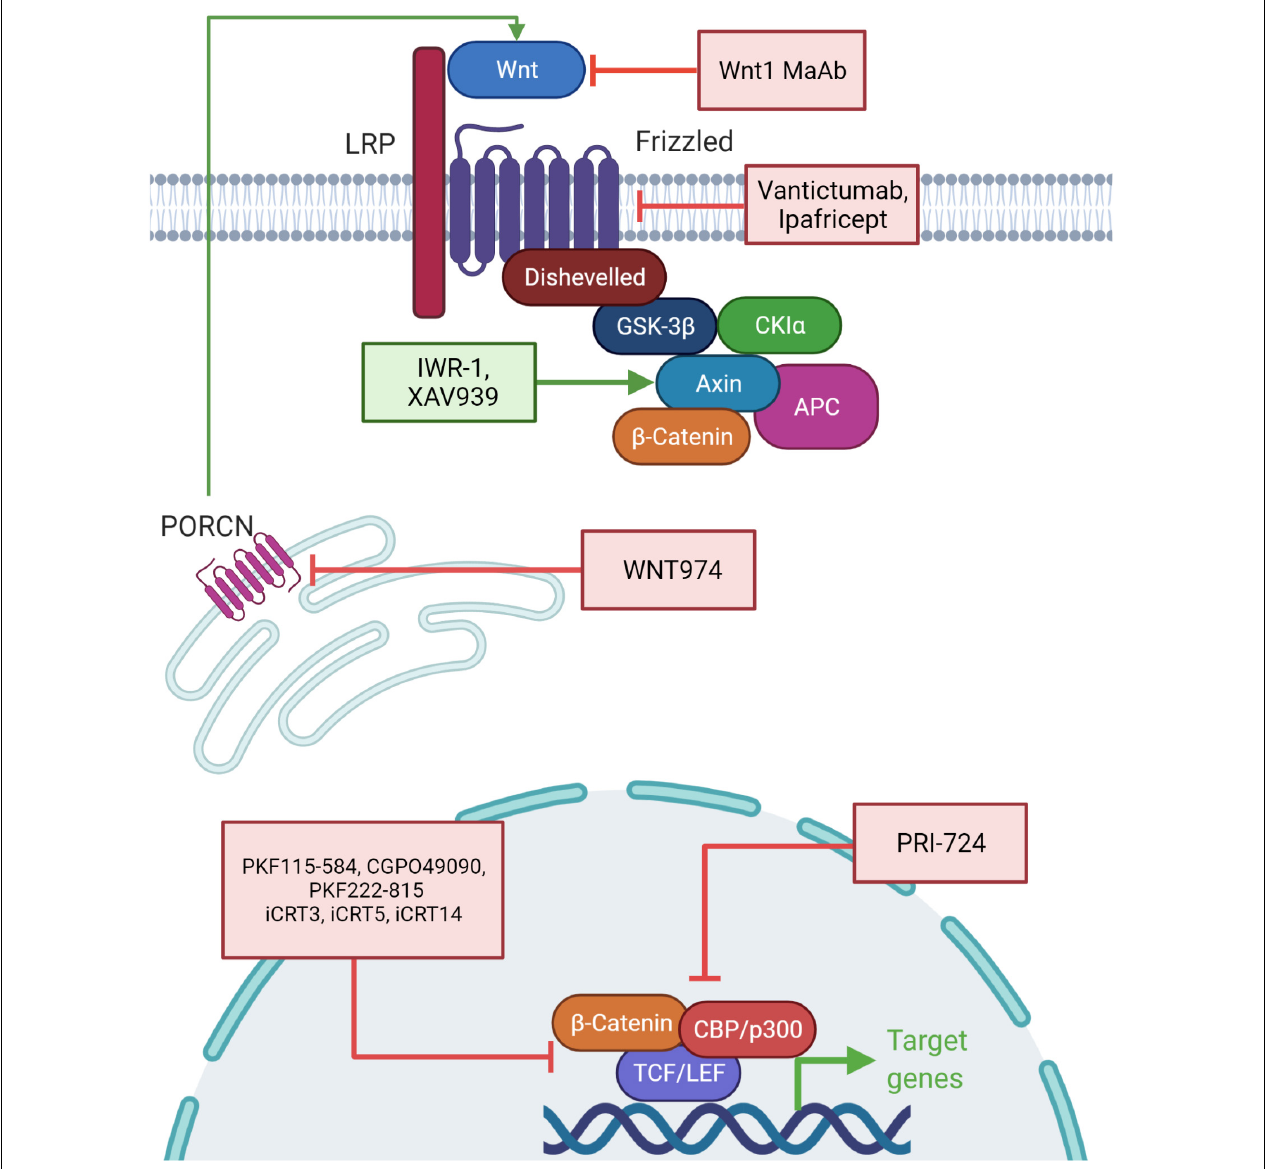
FIGURE 5 | Chemotherapeutic interventions targeting the components of the Wnt signaling pathway. Drugs leading to the activation of the Wnt response inhibitors and repression of the Wnt response activators are being used as therapeutic agents for cancer therapy (or are under clinical trials). Wnt1 monoclonal antibody (MAb), Vantictumab and Ipafricept target the upstream regulators of the Wnt pathway. WNT974 blocks PORCN which prevents processing of Wnt ligands. IWR-1 and XAV939 act by activating AXIN, thereby stabilizing the Wnt destruction complex. PRI-724 acts by inhibiting the interaction of β -catenin with CBP/p300. PKF115-584, CGPO49090, PKF222-815, iCRT3, iCRT5, and iCRT14 act by inhibiting interaction of β -catenin with TCF/LEF.